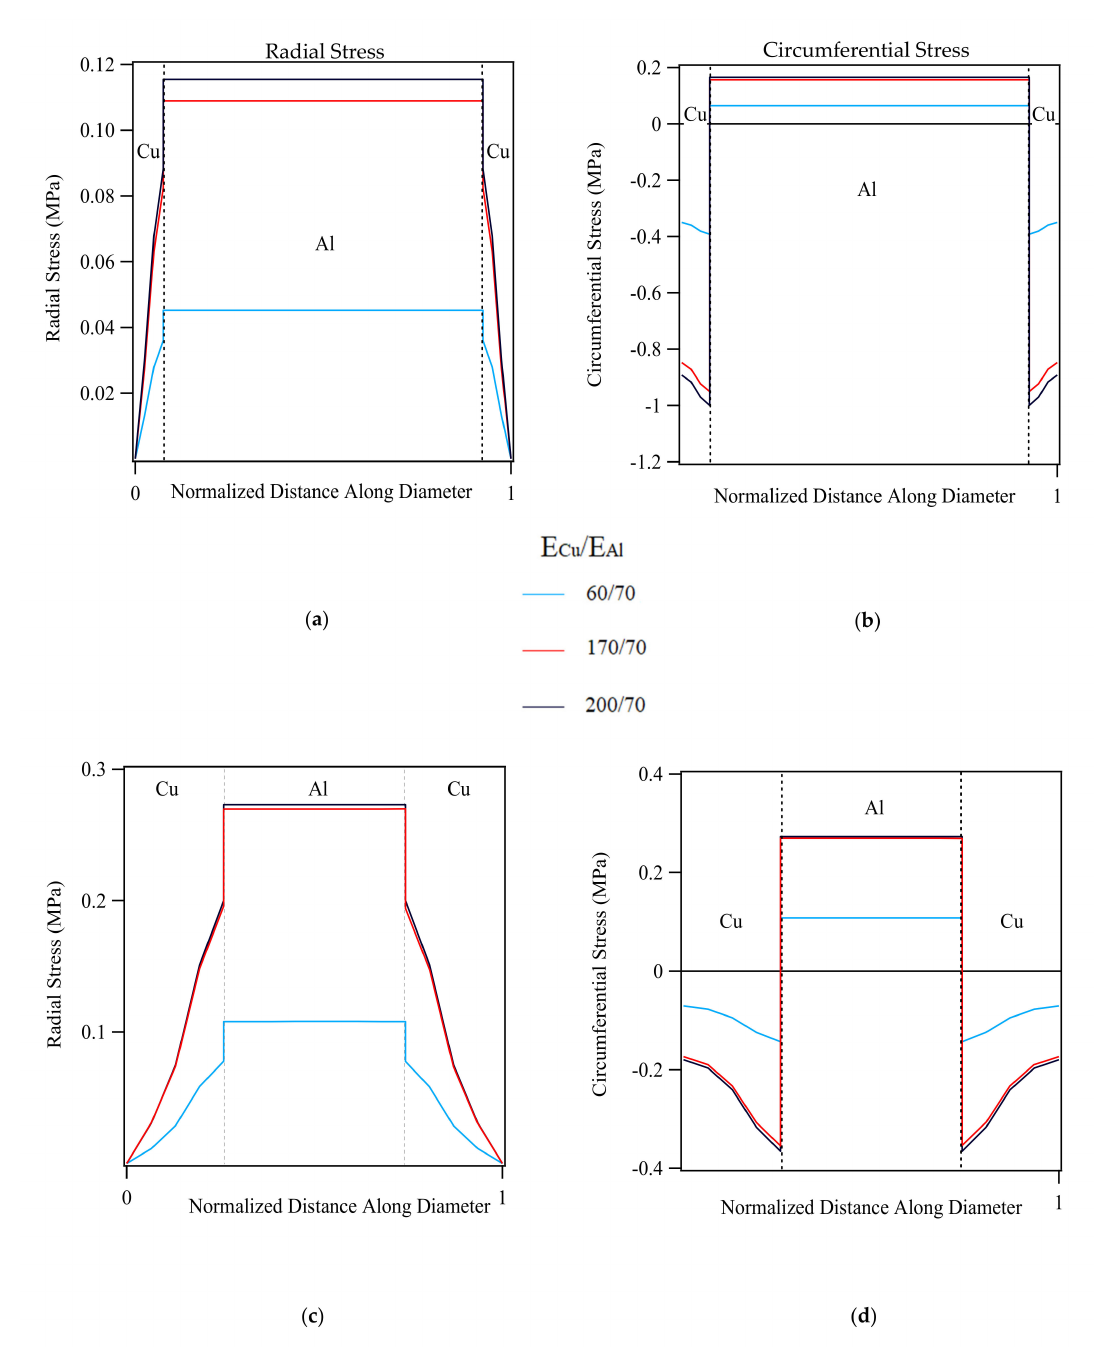
Figure 6. Effect of Young’s modulus and Al/Cu volume fraction on the magnitude and distribution of radial and circumfer- ential stresses ( a , b ) 75%Al-CCA wire ( c , d ) 25%Al-CCA